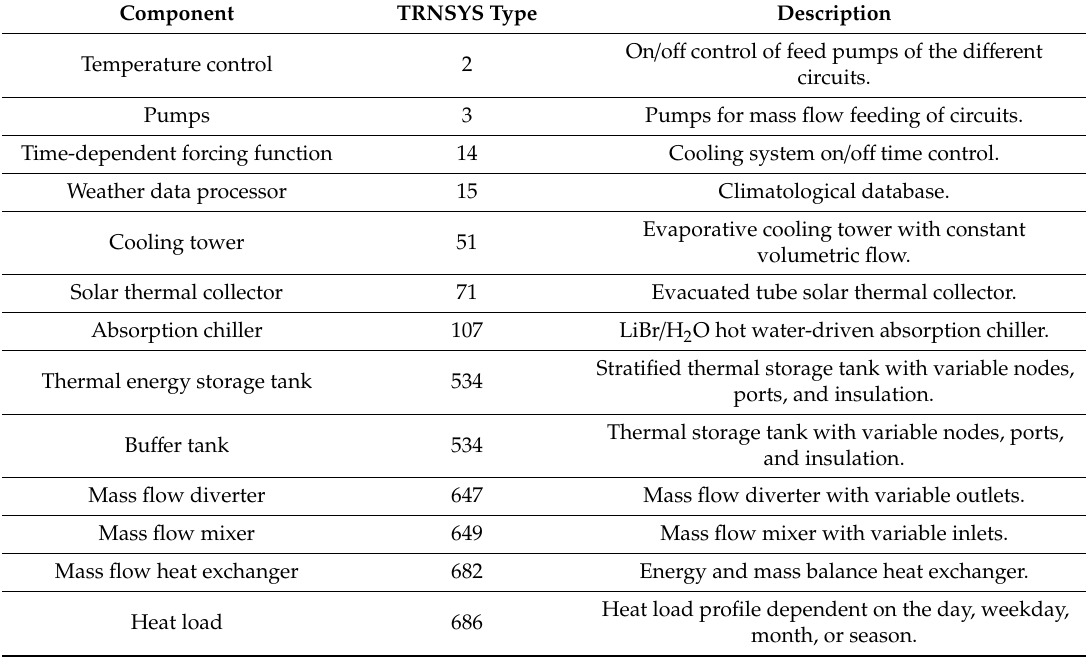
Table 2. TRNSYS type for the components